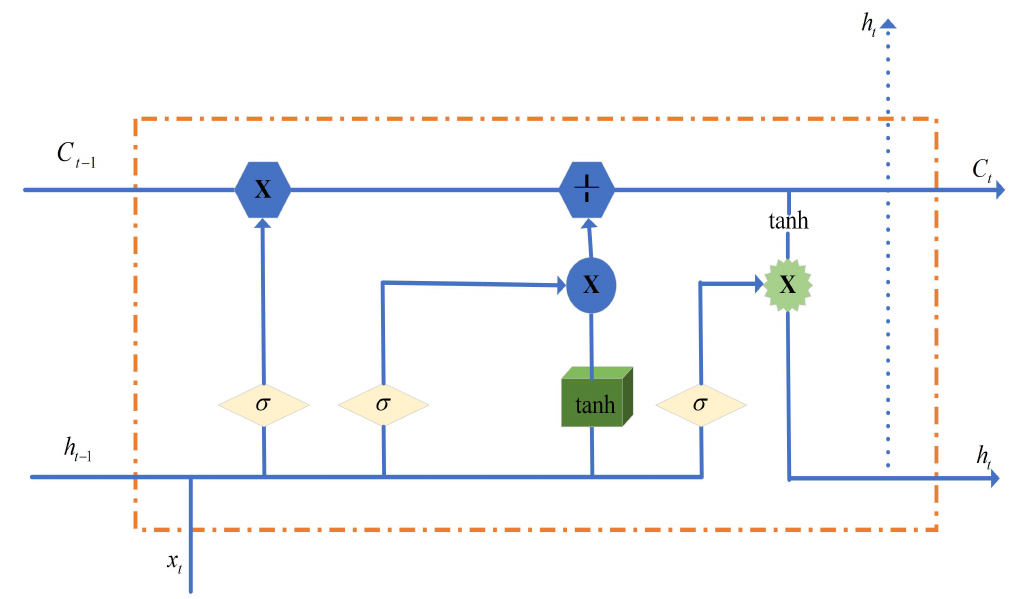
Figure 2. LSTM unit